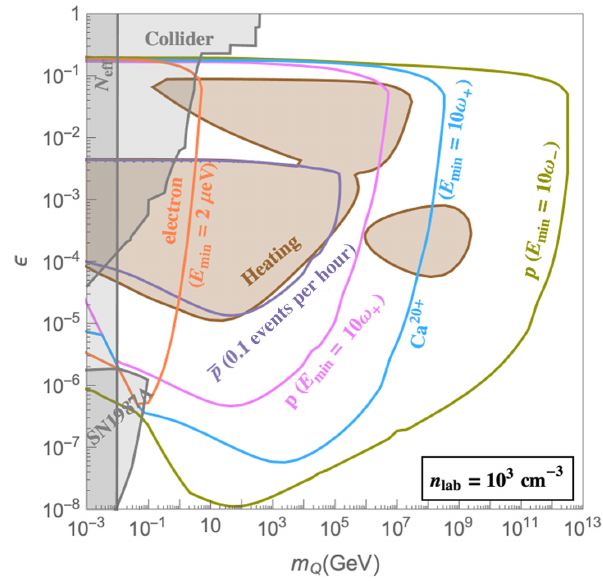
FIG. 5. Event-rate limits and projections for n lab = 10 3 cm − 3 . Existing limits from heating of the ω − mode are shown (brown shaded), from Fig. 2. The projection for a search for single events in the BASE experiment [52] with an energy deposit above 10 ω + and a rate of 0.1 event per hour are shown (dark blue). Here, ω + = 77.4 neV and ω − = 0.050 neV. Next, projections are also shown assuming sensitivity to one-event-per-year event rates. In pink, we show the sensitivity from the existing setup of Ref. [52]. The light blue curve corresponds to swapping a single (anti)proton with hydrogenlike calcium or, equivalently, trapping 361 calcium ions in a Coulomb crystal and measuring its center- of-mass mode. We also show the reach for a futuristic experiment conducted with protons with energy thresholds of E min = 10 ω − in green. Finally, the reach from a hypothetical electron trap with trap frequency ω = 200 neV and E min = 2 μ eV is shown in